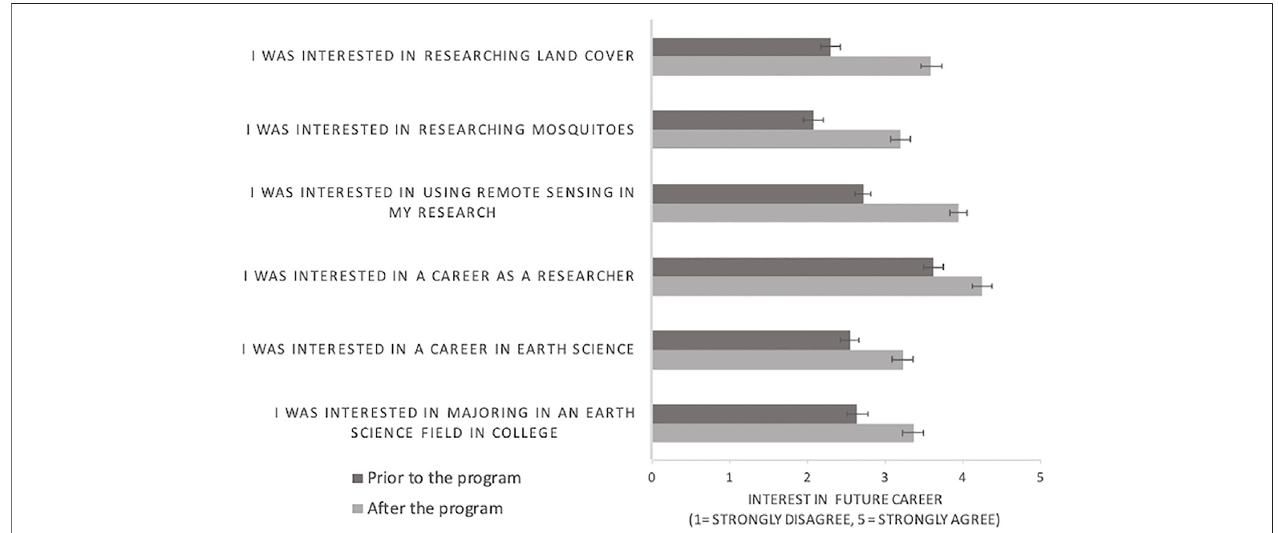
FIGURE1| Thedifferenceininterns ’ responsestoaseriesofLikert-scalequestionsqueryingtheirlevelofinterestinvariousSTEMandEarthsciencerelatedcareer pathways prior to the program and after the program (n (cid:1) 60). Responses were measured on a 5-point Likert scale, with 1 (cid:1) Strongly disagree and 5 (cid:1) Strongly agree.